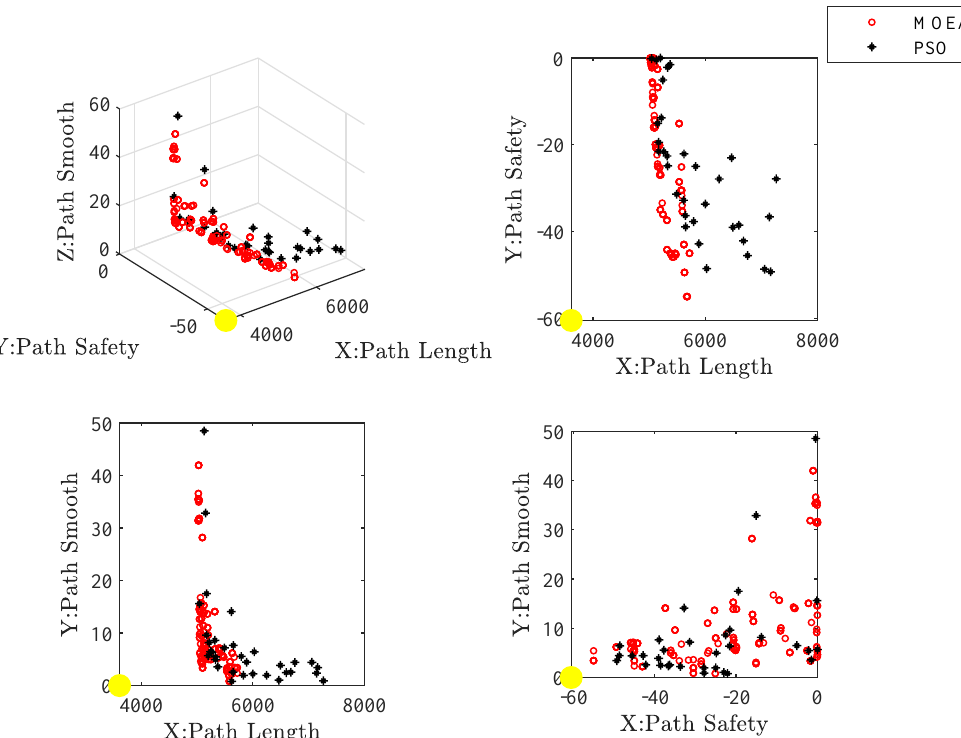
Figure 9. Approximate Pareto fronts for Figure 8A: MOEA vs. PSO.